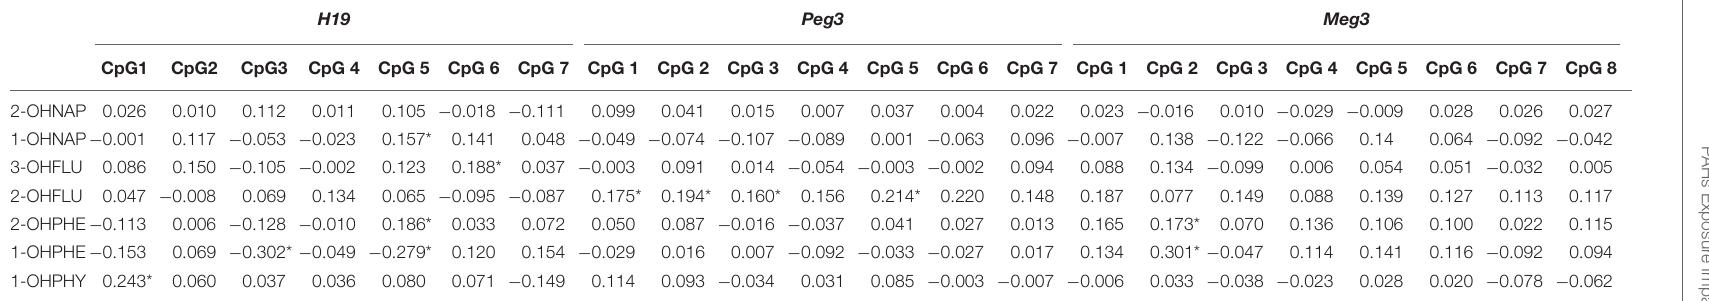
TABLE 6 | Spearman correlation analysis between individual methylation levels CpGs of H19, Peg3, and Meg3 and